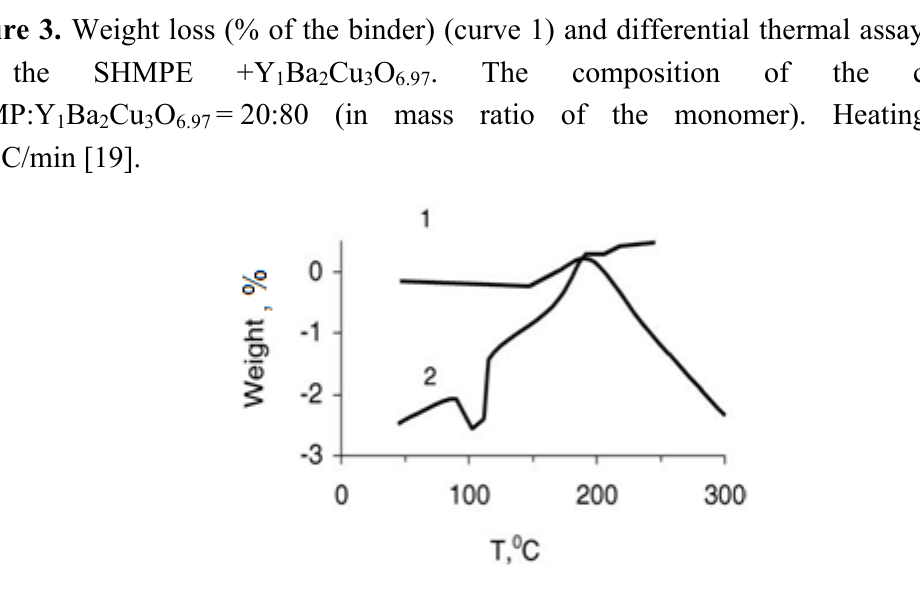
Figure 4. The curve of SC transition for the composition obtained during polymerization of MMA in the pressed samples of the Y weight ratio: 88:12